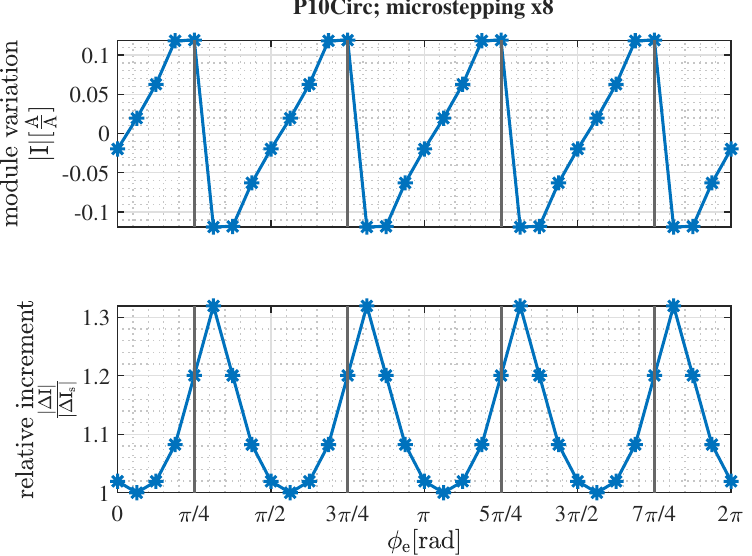
Figure 8. Torque variation and increment relative to a sine-cosine microstepping of equal resolution. For p = 10 resolution, x8 becomes too low to guarantee the drop in torque variation at φ e = π + k π